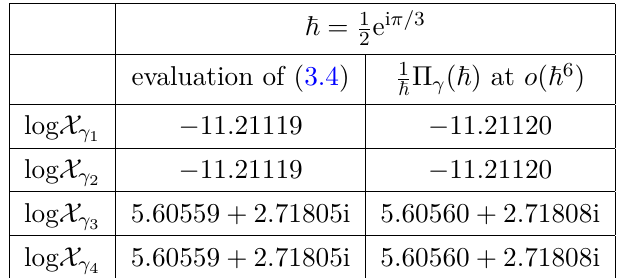
Table 3 . Comparison of log X γ with the formal quantum periods expansion up to order- ~ 6 at ~ = 1 e i π/ 3 for equation B of (1.12), where we have set u 2